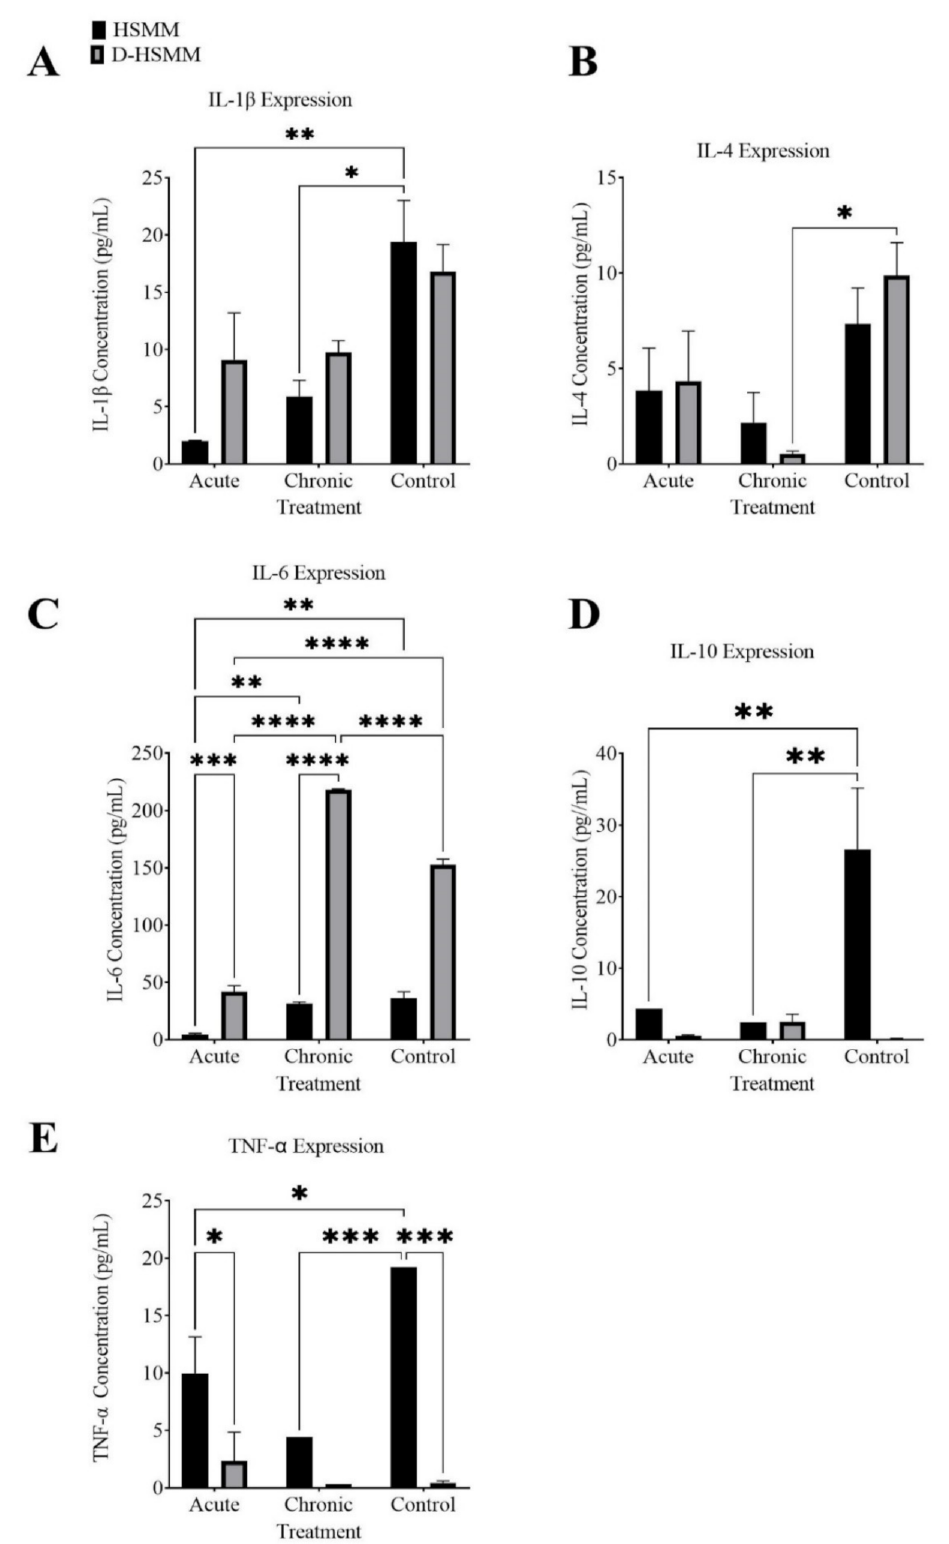
Figure 4. Cytokine concentrations: ( A ) Interleukin-1 β ; ( B ) Interleukin-4; ( C ) Interleukin-6; ( D ) Interleukin-10; ( E ) Tumor necrosis factor- α , as calculated. The significance was determined when p ≤ 0.05 (*), p ≤ 0.01 (**), p ≤ 0.001 (***), or p ≤ 0.0001